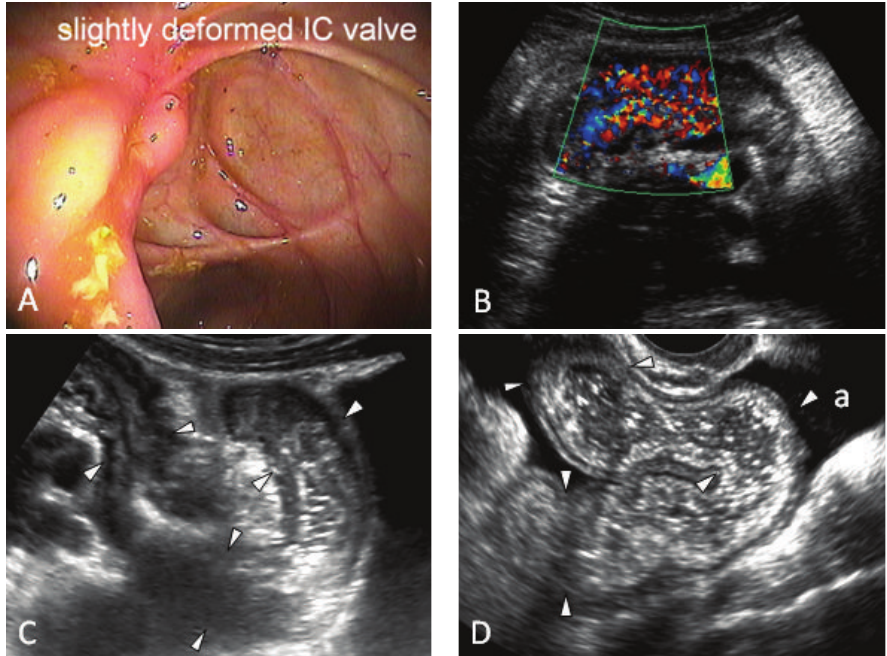
Figure 3: Stricture. 27-year-old female with no prior diagnosis of Crohn’s disease with a failure to intubate the terminal ileum on colonoscopy due to a deformity at the ileocecal (IC) valve shown in (A). (B) An ultrasound image of the terminal ileum shows that it is thick-walled and hyperemic. (C) Additional ultrasound image shows a fixed acute angulation of the bowel. (D) shows the bowel proximal to the angulation with increased calibre and increased fluid content. There is ascites (a). Interpretation: hyper- and dysfunctional peristalsis on real-time imaging indicated acute inflammatory stricture with incomplete mechanical bowel obstruction. Biological therapy was initiated after